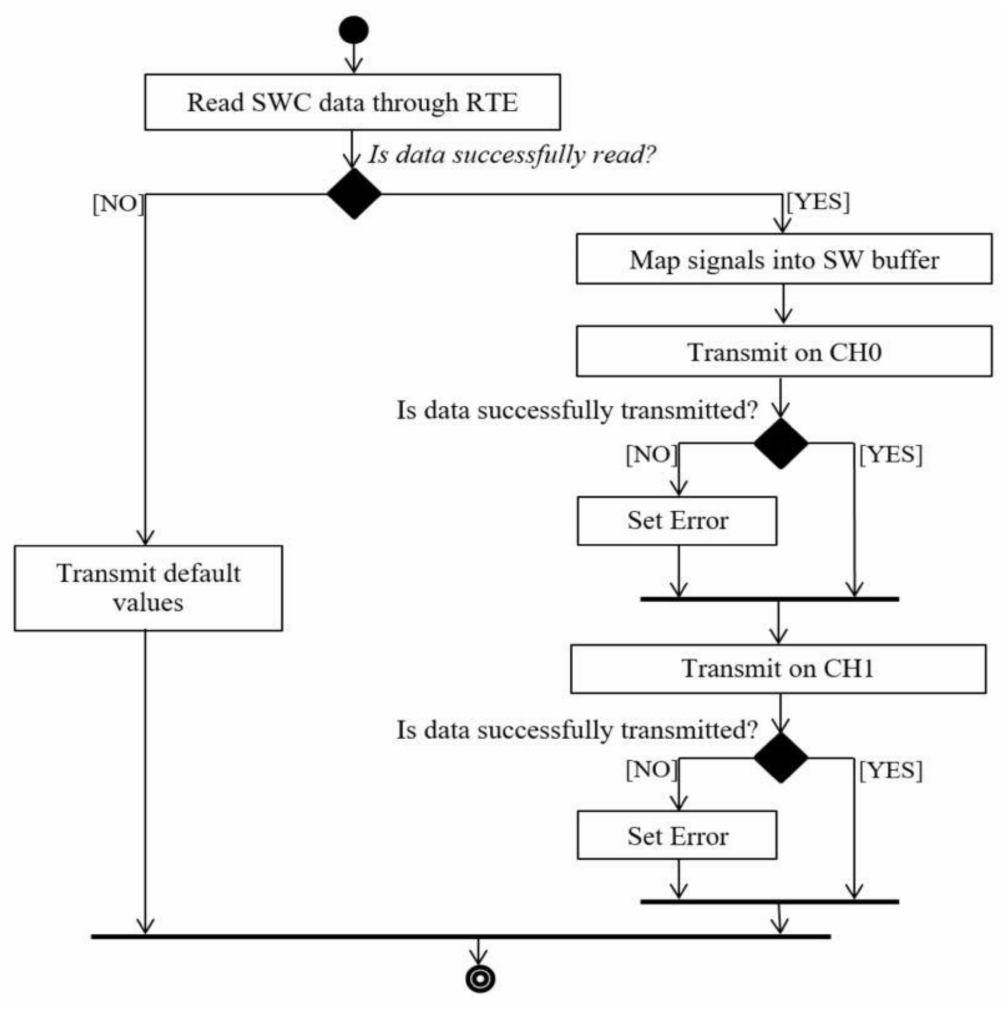
Figure 9. Message transmission